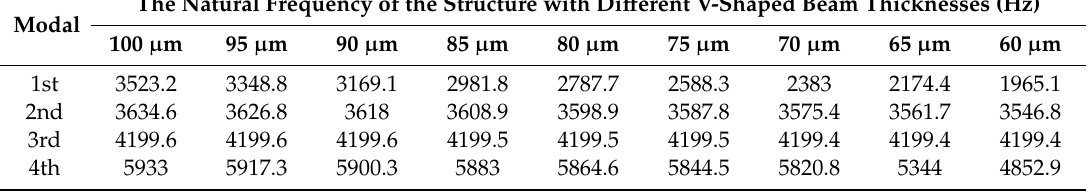
Table 2. The first 4th natural frequency of the structure with di ff erent V-shaped beam thicknesses.